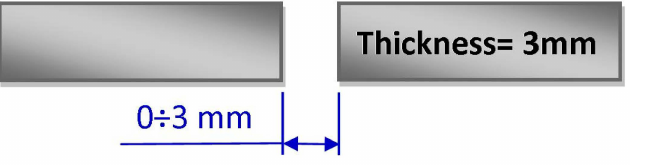
Figure 1. Preparation of the element for metal active gas (MAG) welding with micro-jet cooling.